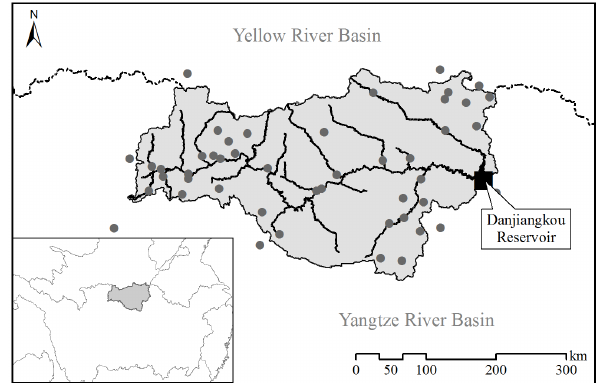
Fig. 1. Location of upper Hanjiang River basin (UHRB) in China. Figure 1. Location of upper Hanjiang River basin (UHRB, denoted as shaded region in the 590 Dashed line is the boundary of the Yangtze River basin. The grey figure) in China. Dashed line is the boundary of the Yangtze River basin. The grey dots are rain 591 dots are rain gauges. The black square is Danjiangkou reservoir sta- gauges. The black square represents the location of Danjiangkou Reservoir station. 592